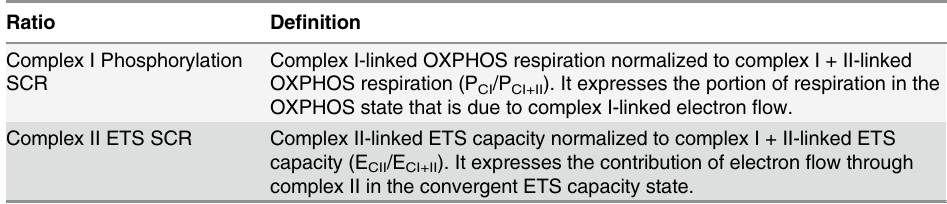
Table 3. Definitions of the substrate control ratios (SCRs) used.